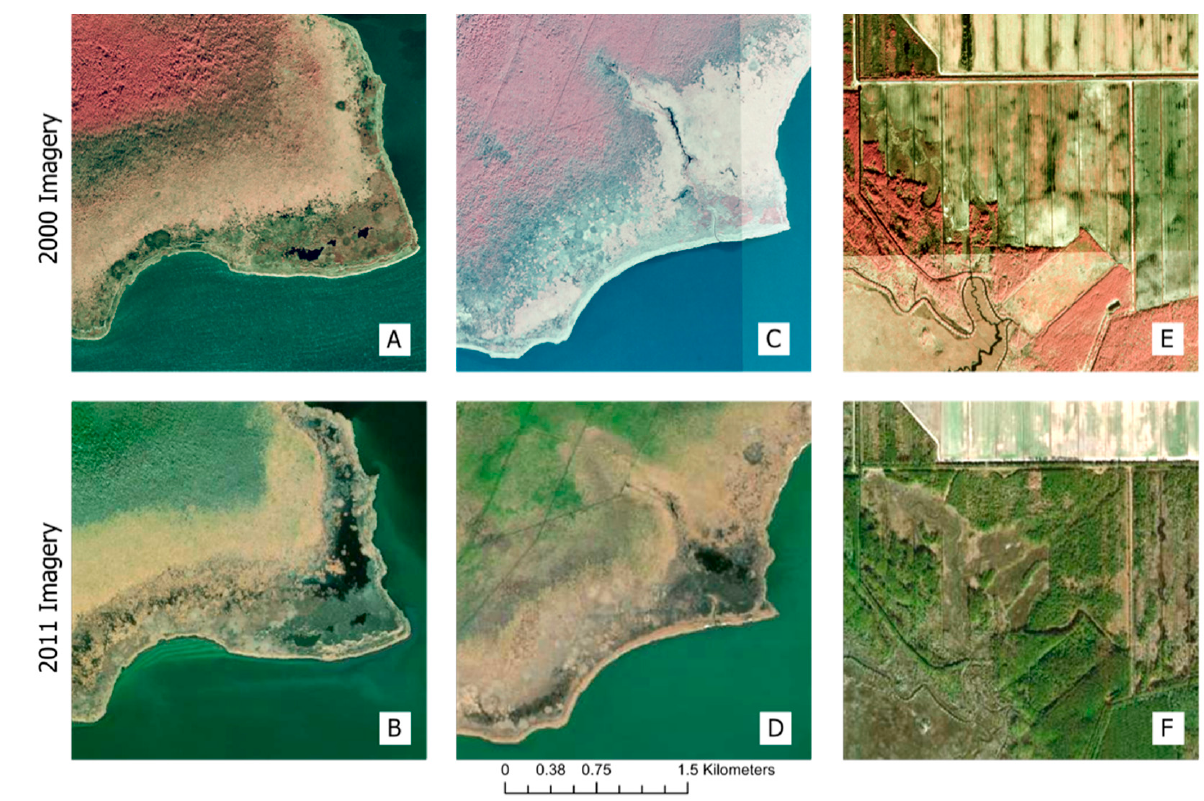
Figure 2. Comparisons of areas along the coastal plain in high resolution imagery from 2000 and 2011. Note that 2000 imagery is shown in false color (NIR-R-G) and 2011 imagery is in true color. Panels ( A – D ) show the encroachment of wetland into forested areas. Panels ( E , F ) show what was initially agriculture turning into a wetland forest.